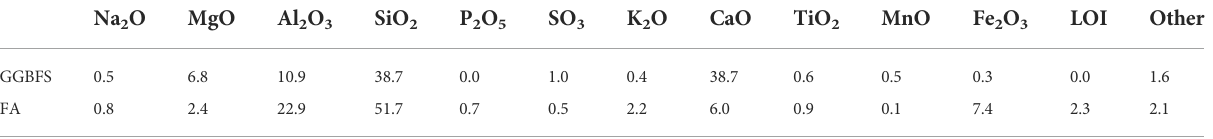
TABLE 1 Chemical composition of the raw materials in ma% measured using WD XRF.